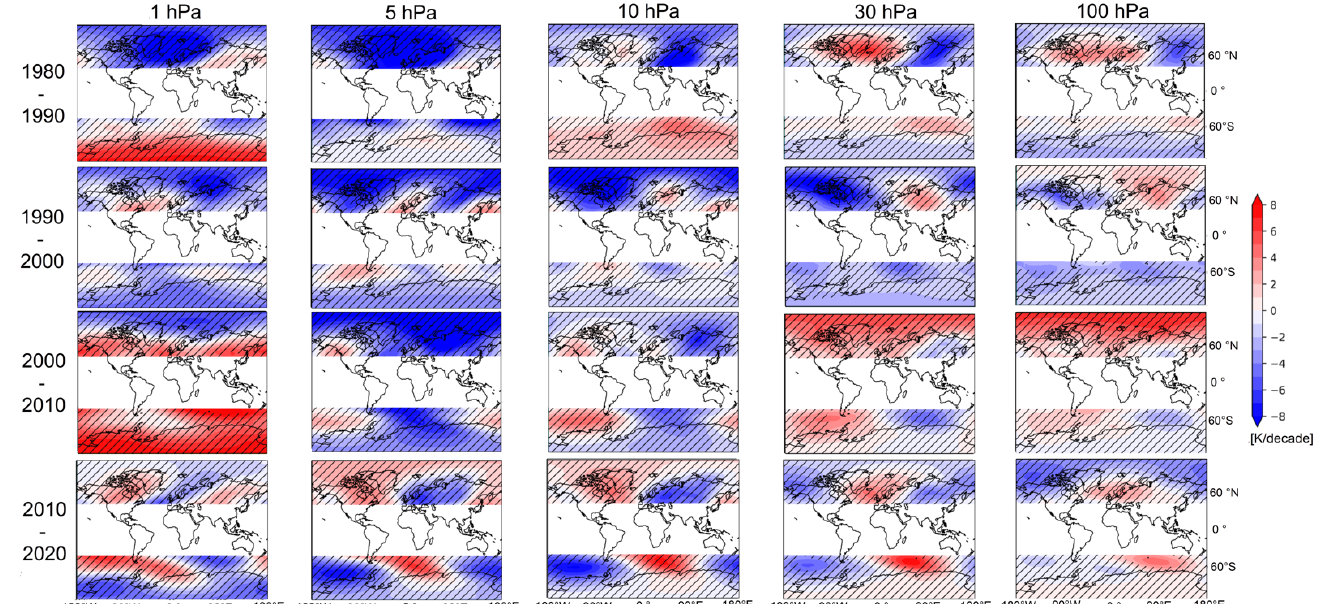
Figure 4. Temperature trend (K/dec) for 1980–1990, 1990–2000, 2000–2010 and 2010–2020 using ERA5 reanalysis at 1, 5, 10, 30 and 100 hPa.